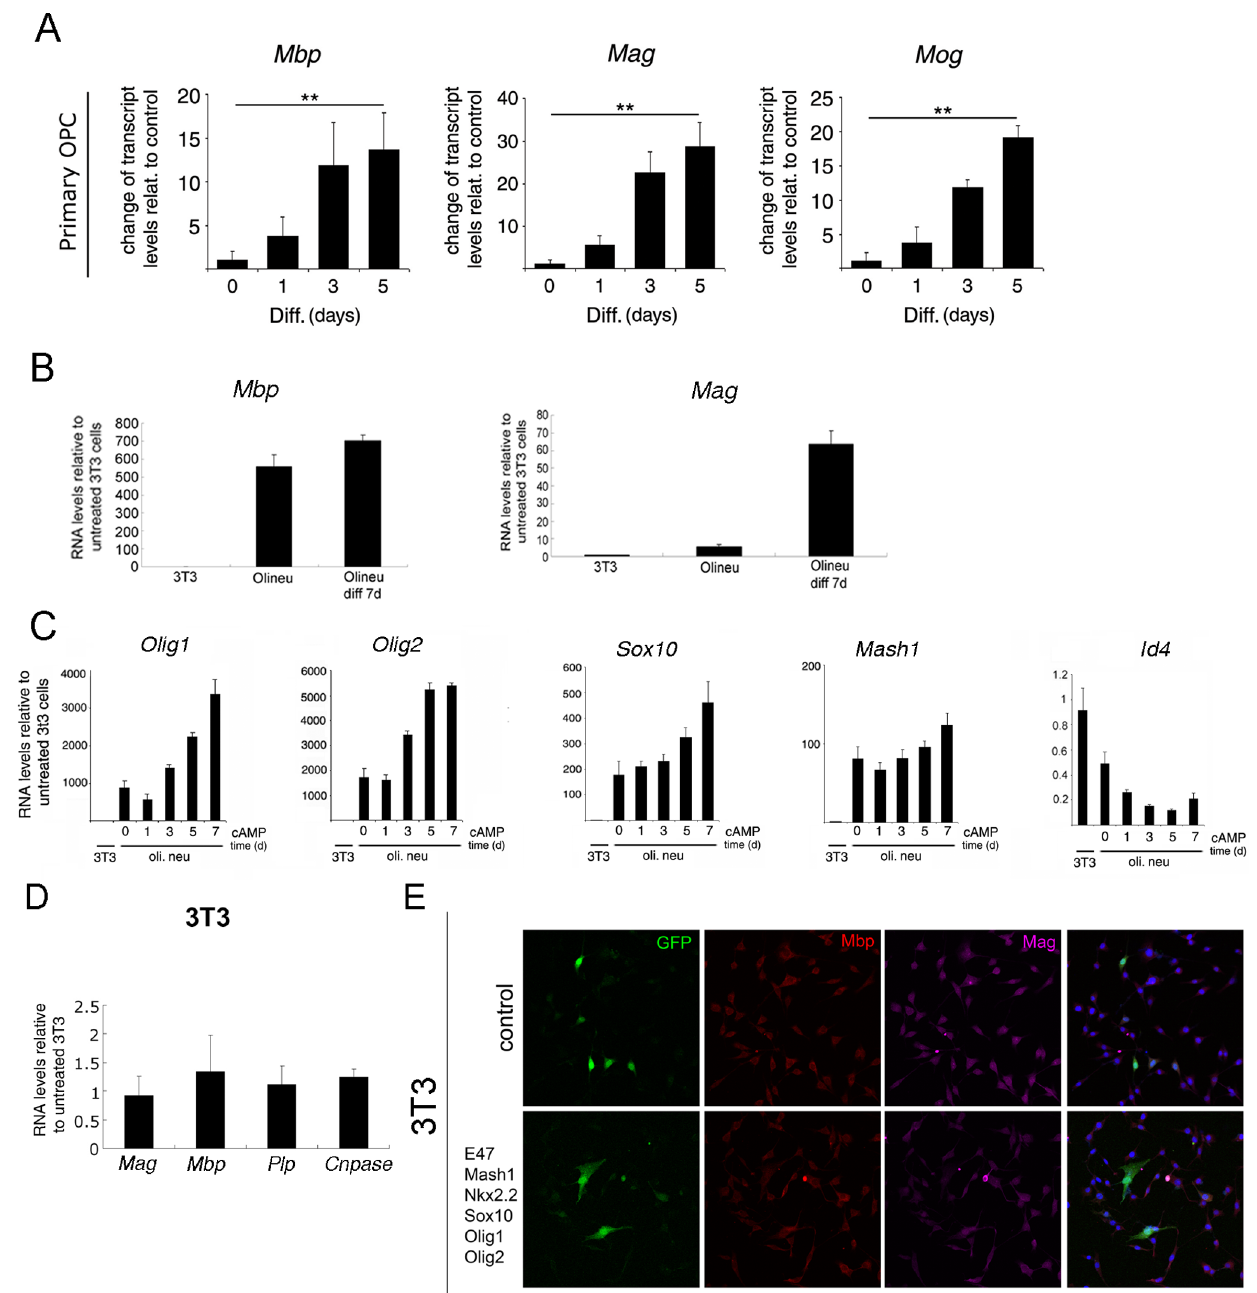
Figure 1. Transfection of oligodendrocyte-specific transcription factors is not sufficient to express endogenous myelin genes in fibroblasts. Temporal pattern of regulation of myelin gene expression in rat primary oligodendrocyte progenitors during differentiation (A). Transcript levels of Mbp , Mag and Mog were analyzed by quantitative RT-PCR in rat primary progenitors and in differentiated cells at the indicated time points (1, 3 and 5 days). Transcript levels of myelin genes (B) and oligodendrocyte-specific transcription factors (C) were analyzed by qRT-PCR in non-myelinating (NIH3T3) and in myelinating (Oli neu ) cell lines differentiated with cAMP for multiple time points (DIV 0,1,3,5,7). The effect of transfecting combinations of positive transcription factors ( E47 , Mash1 , Nkx2.2 , Sox10 , Olig1 and Olig2 ) was assessed by detecting myelin gene transcripts using qRT-PCR (D) and myelin proteins, using immunocytochemistry (E). Values were normalized by the levels of Gapdh and shown as relative to the levels detected in untreated sample. The bar graphs represent the average values and error bars represent standard deviations (n=3; * p , 0.05; ** p , 0.01; *** p , 0.001). doi:10.1371/journal.pone.0013023.g001 activity (i.e. trimethylated lysine 4 on histone 3 (me3K4H3) and The histone code used by different cell types to allow or limit the pan acetylated H3 (AcH3)) as well as those associated with accessibility of transcription factors to myelin gene loci, was then transcriptional repression (i.e. trimethylated lysine 9 on histone 3 studied using chromatin immunoprecipitation (ChIP) with anti- (me3K9H3) and trimethylated lysine 27 on histone 3 bodies against histone marks associated with transcriptional